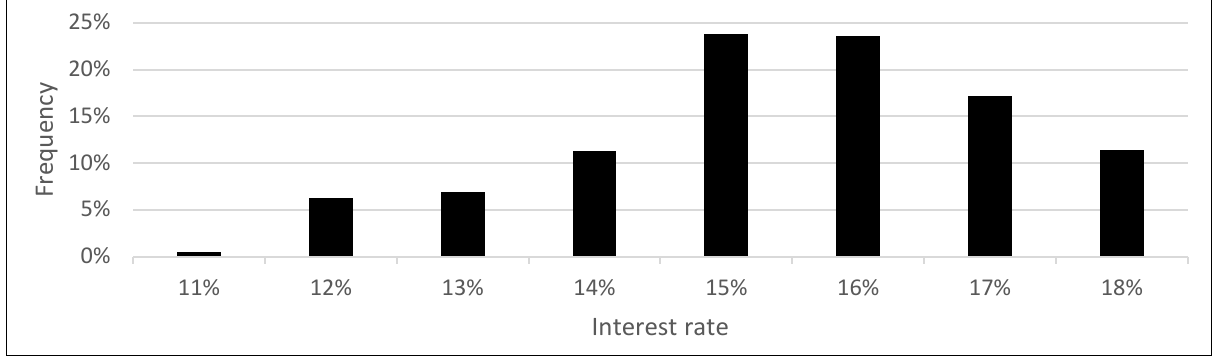
Figure 2: Interest rates offered for home loans analysed.